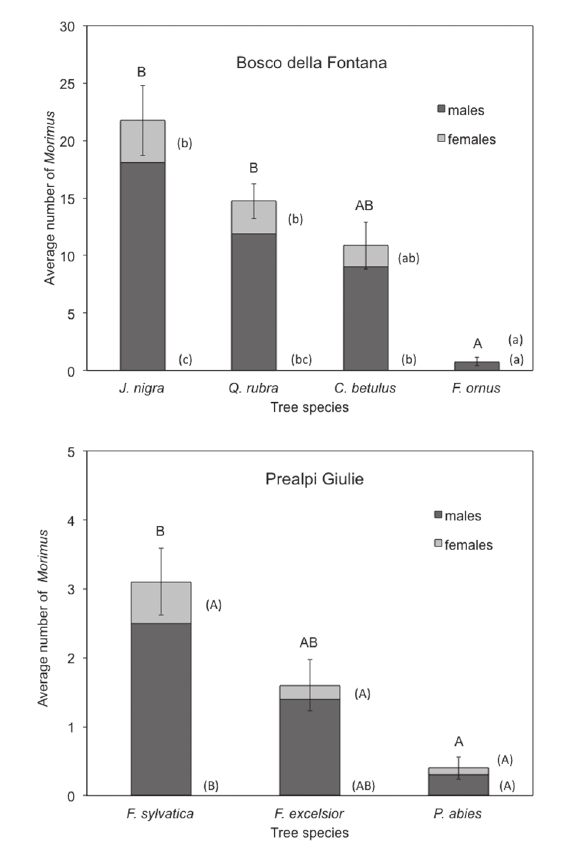
Figure 8. Average number (±SE) of adults of M. asper observed per day on single wood piles built from wood of different tree species. Different capital and small letters above columns (total adults) and on the right (males and females) indicate significant differences amongst wood types at the 0.01 and 0.05 levels respectively (Dunn’s Multiple Comparisons Test) (see text for details). Figures from Leonarduzzi et al.